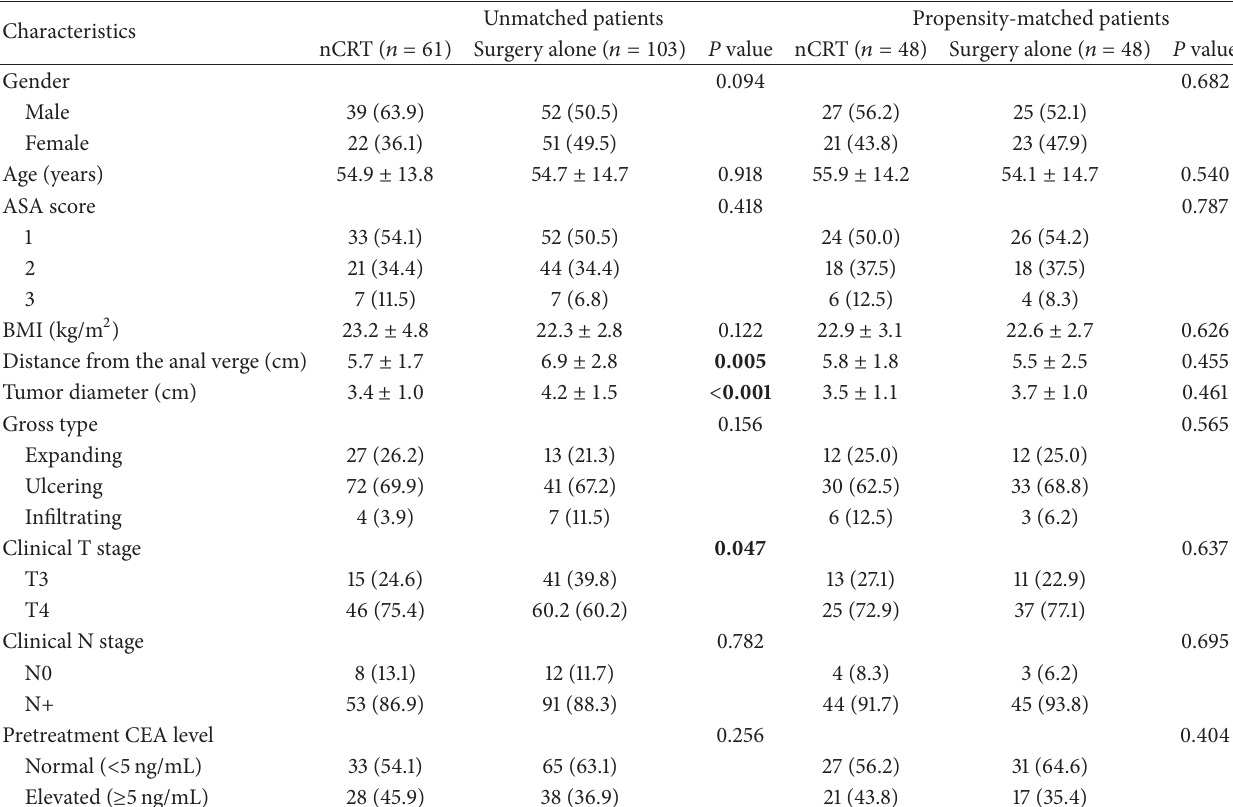
Table 1: Patient characteristics in unmatched and propensity-matched rectal mucinous adenocarcinomas.